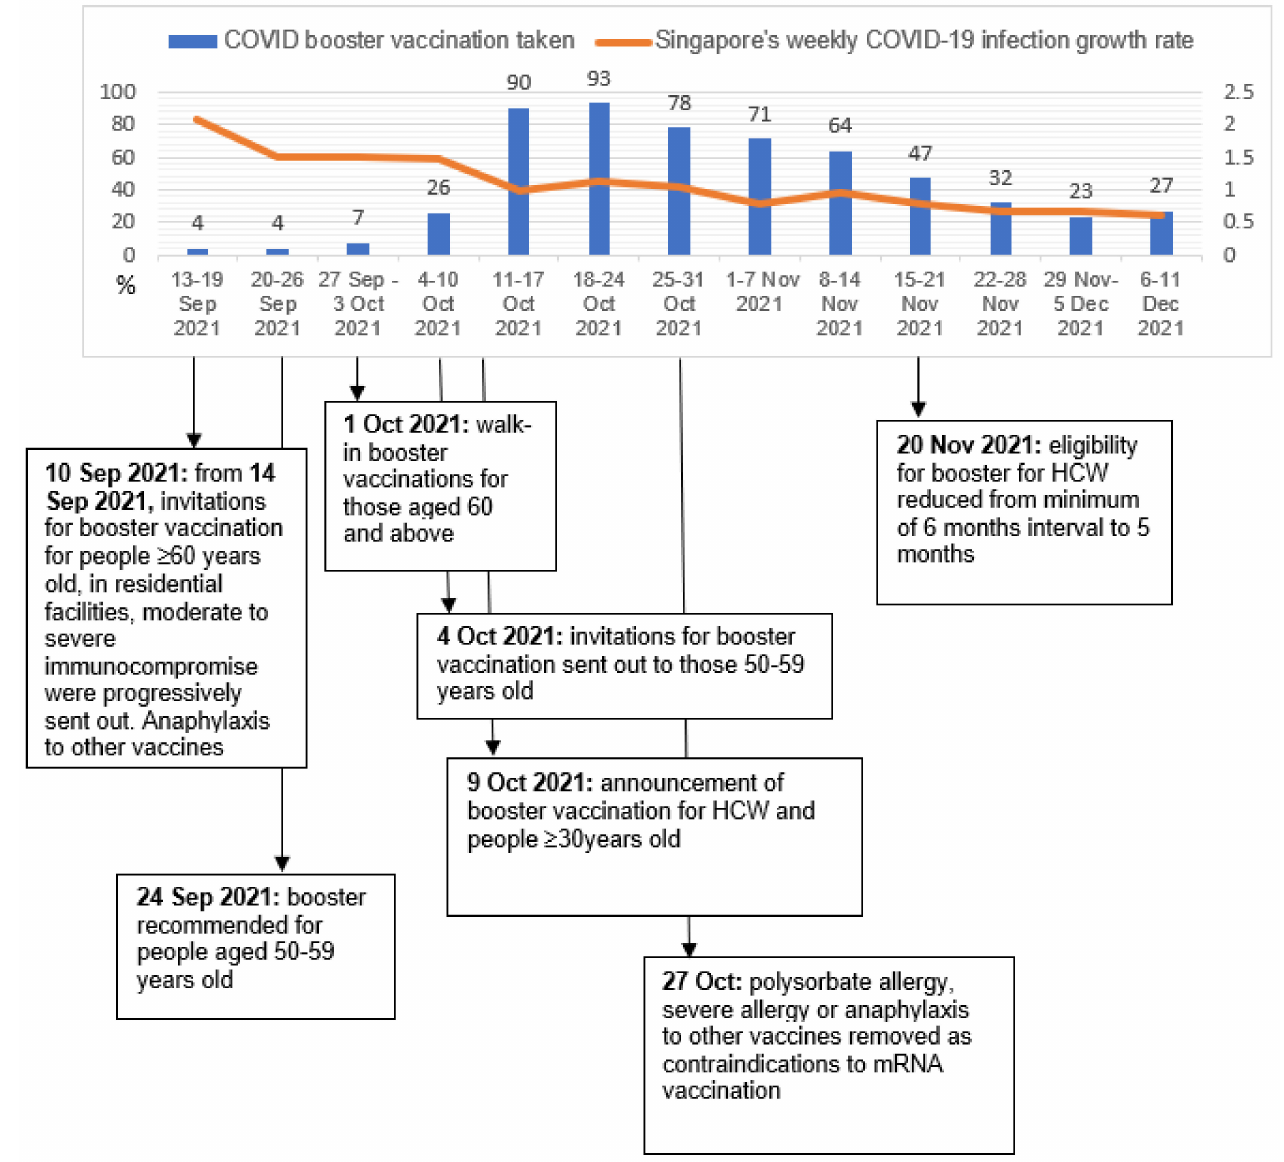
Figure 2. Timeline of COVID-19 booster uptake in relation to policy changes and local infection